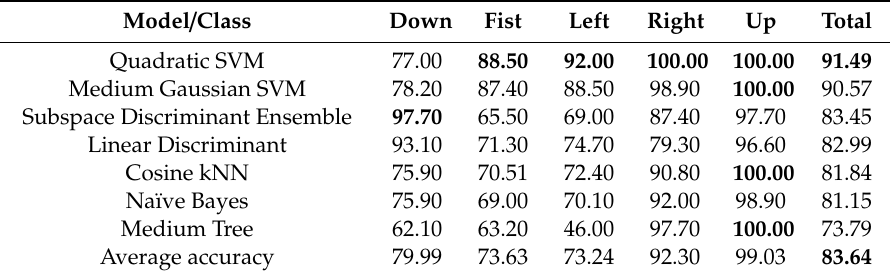
Table 2. Comparison of accuracy percentage among various machine learning algorithms for the gesture classification problem (maximum accuracies marked in bold font